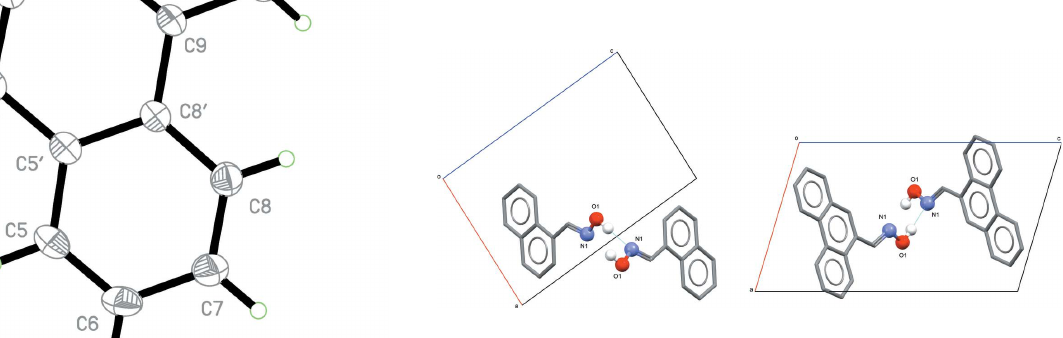
Figure 3 Intermolecular hydrogen-bonding associations for (I) (left) and (II) (right), shown as dashed lines. Non-associative H atoms have been omitted for